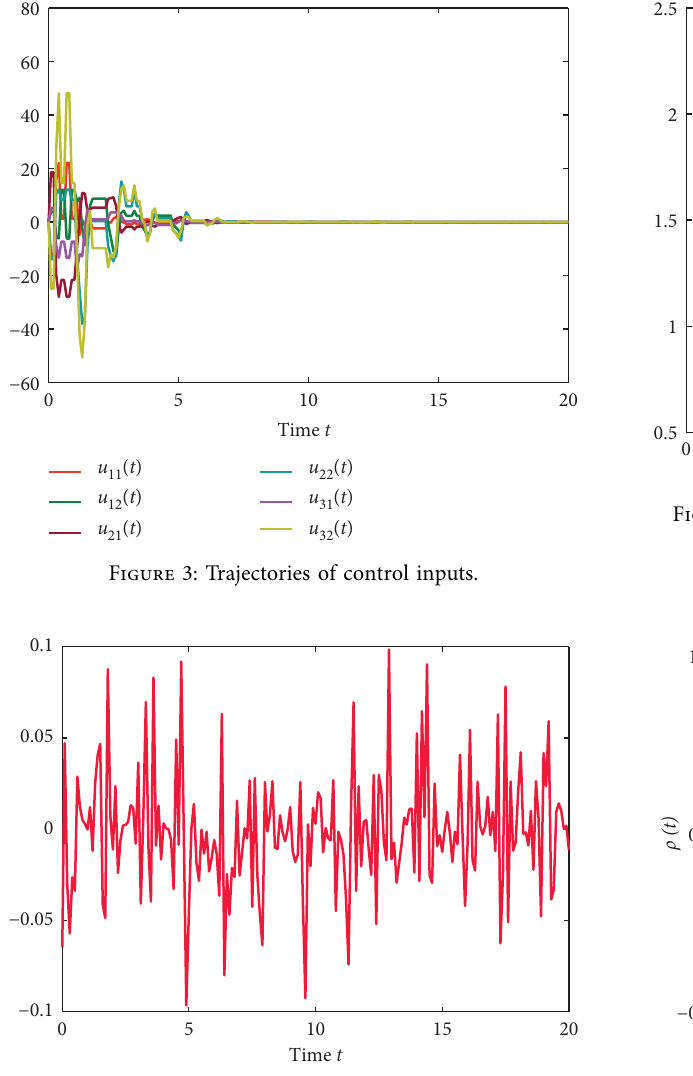
Figure 4: Response of disturbance.